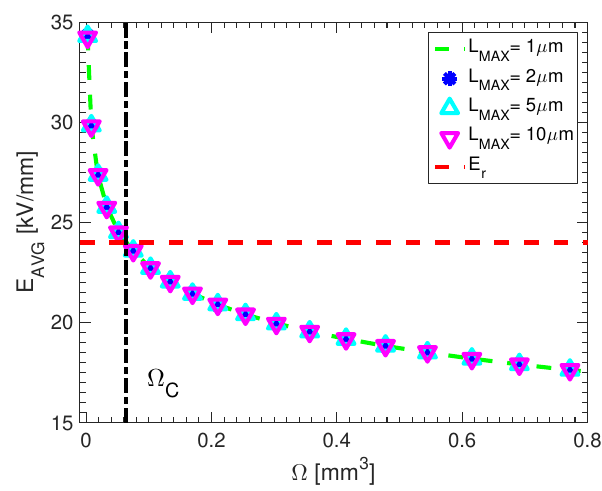
Figure 6: Average electric field E AVG as a function of the control volume Ω . The critical control volume Ω C is the Ω where E AVG = E r , where E r is the material dielectric